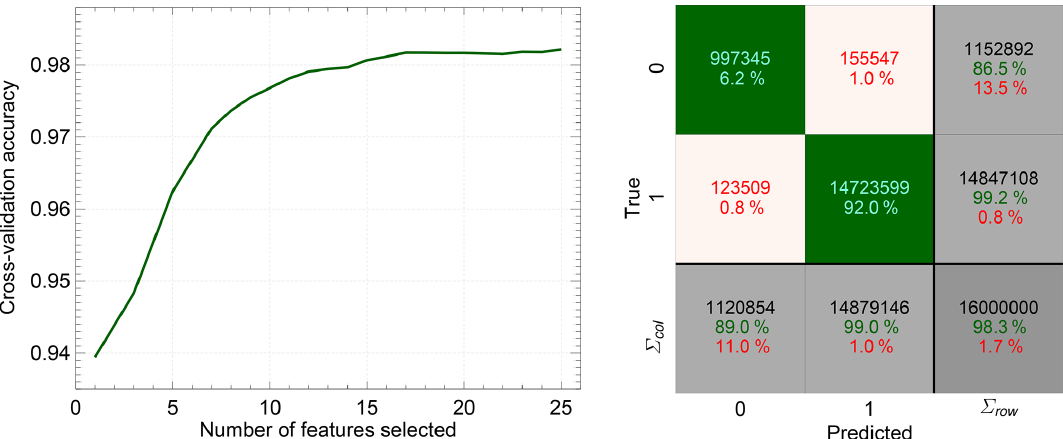
Figure 7. Cross-validated predictive accuracy of the quality classification random forest obtained by recursive feature elimination. The confusion matrix when using all 25 features is shown on the right-hand side for the test data set, denoting good observations with 0 and measurements to be excluded with 1. The green diagonal cells correspond to correct classifications and the red off-diagonal cells to incorrect classifications. The number of scenes and the percentage of the total number of scenes are given in each cell. Important key parameters are summarised in the grey cells along the edge. The right column shows the percentages of all the elements belonging to each class that are correctly (recall) and incorrectly (false negative rate) classified and the bottom row those that are predicted to belong to each class that are correctly (precision) and incorrectly (false discovery rate) classified. The dark grey cell in the bottom right corner displays the overall